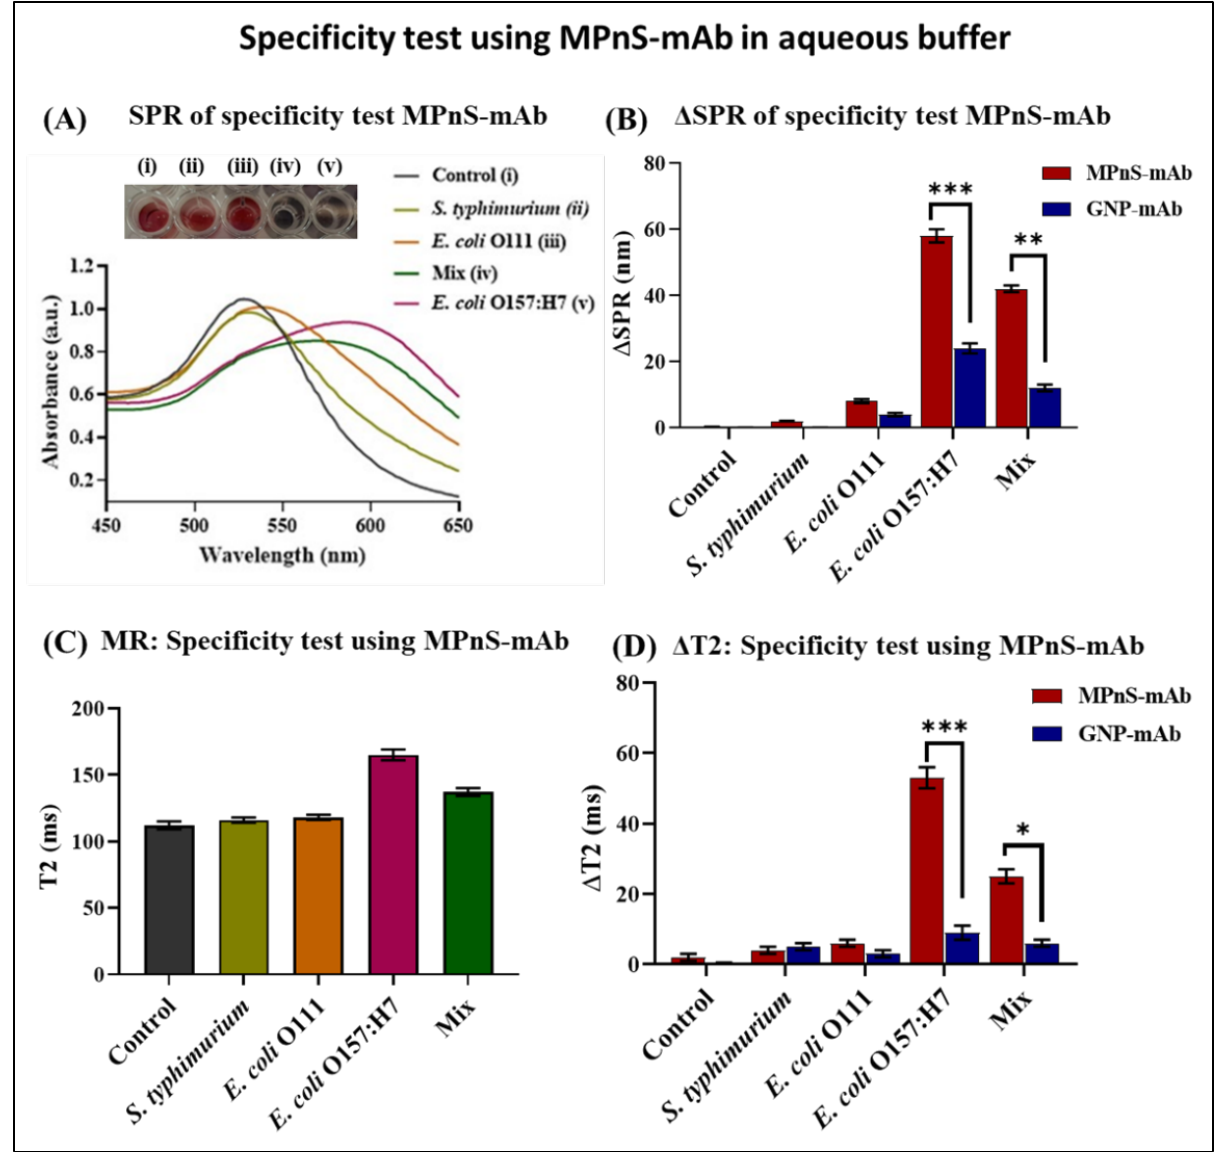
Figure 3. Specificity of antibody-conjugated MPnS in the presence of other bacterial cross-contaminants and compared with functional GNPs: ( A ) Specificity test was conducted in the presence of non-target pathogens by collecting UV-Vis data and colorimetric readout, and ( B ) compared with GNPs-mAb for target bacteria E. coli O157:H7 detection. In ( C , D ), additional specificity testing was performed by monitoring changes in T2 MR values. Statistically significant differences ( p < 0.001 or ***, 0.01 or **, and 0.1 or *) were observed when data points for MPnS-mAb and GNP-mAb were compared for E. coli O157:H7 and Mix.